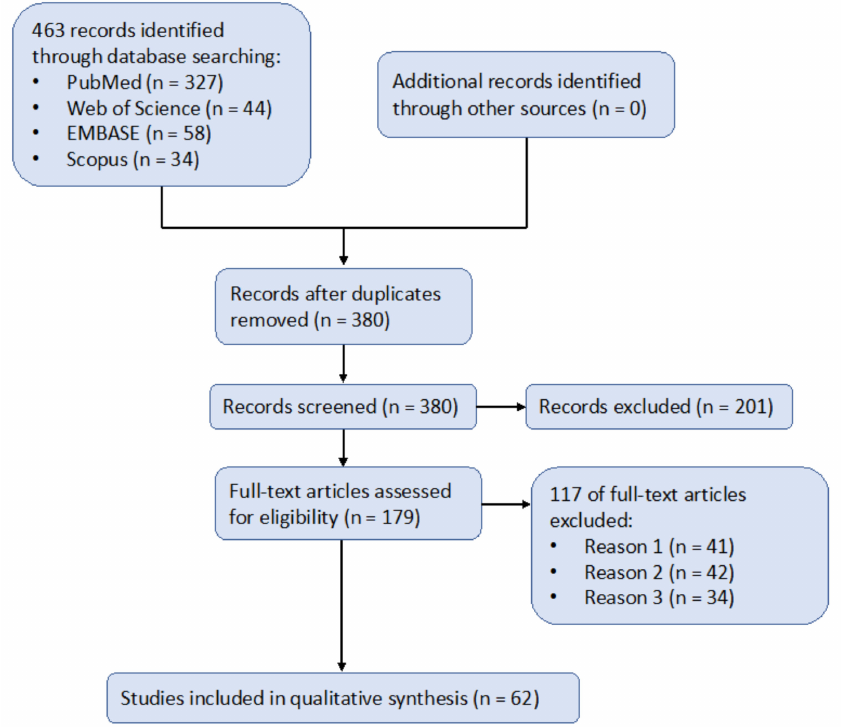
Figure 1. Flow chart of the literature search following PRISMA 2020 guidelines. Searching databases were used as detailed in the main text. The reasons for exclusion of articles were as follows. Reason 1: stem cell was mentioned not as a direct therapeutic method, but as a medium for other medical treatments or preclinical research. Reason 2: the article included brief mentioning of Alzheimer’s disease, but was not targeted toward Alzheimer’s disease. Reason 3: Ineligible exposure